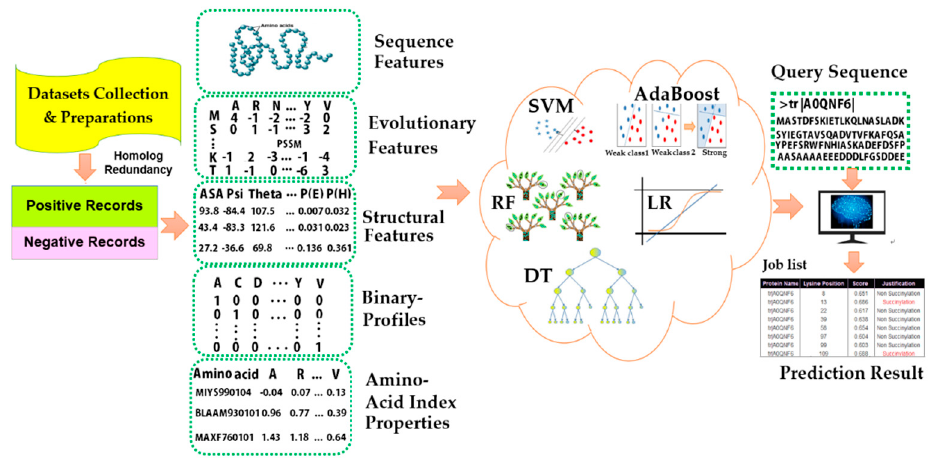
Figure 1. An overview of current computational prediction algorithms of succinylation sites.